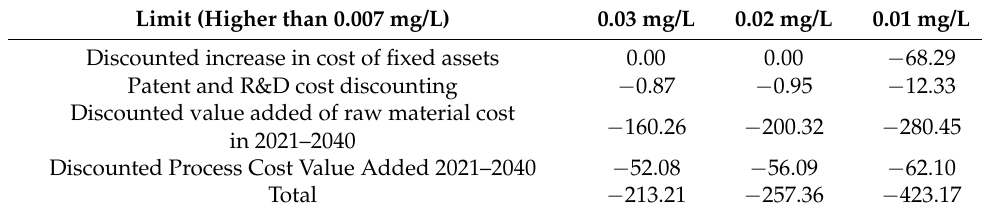
Table 9. Industrial economic loss and gain due to the limit change.